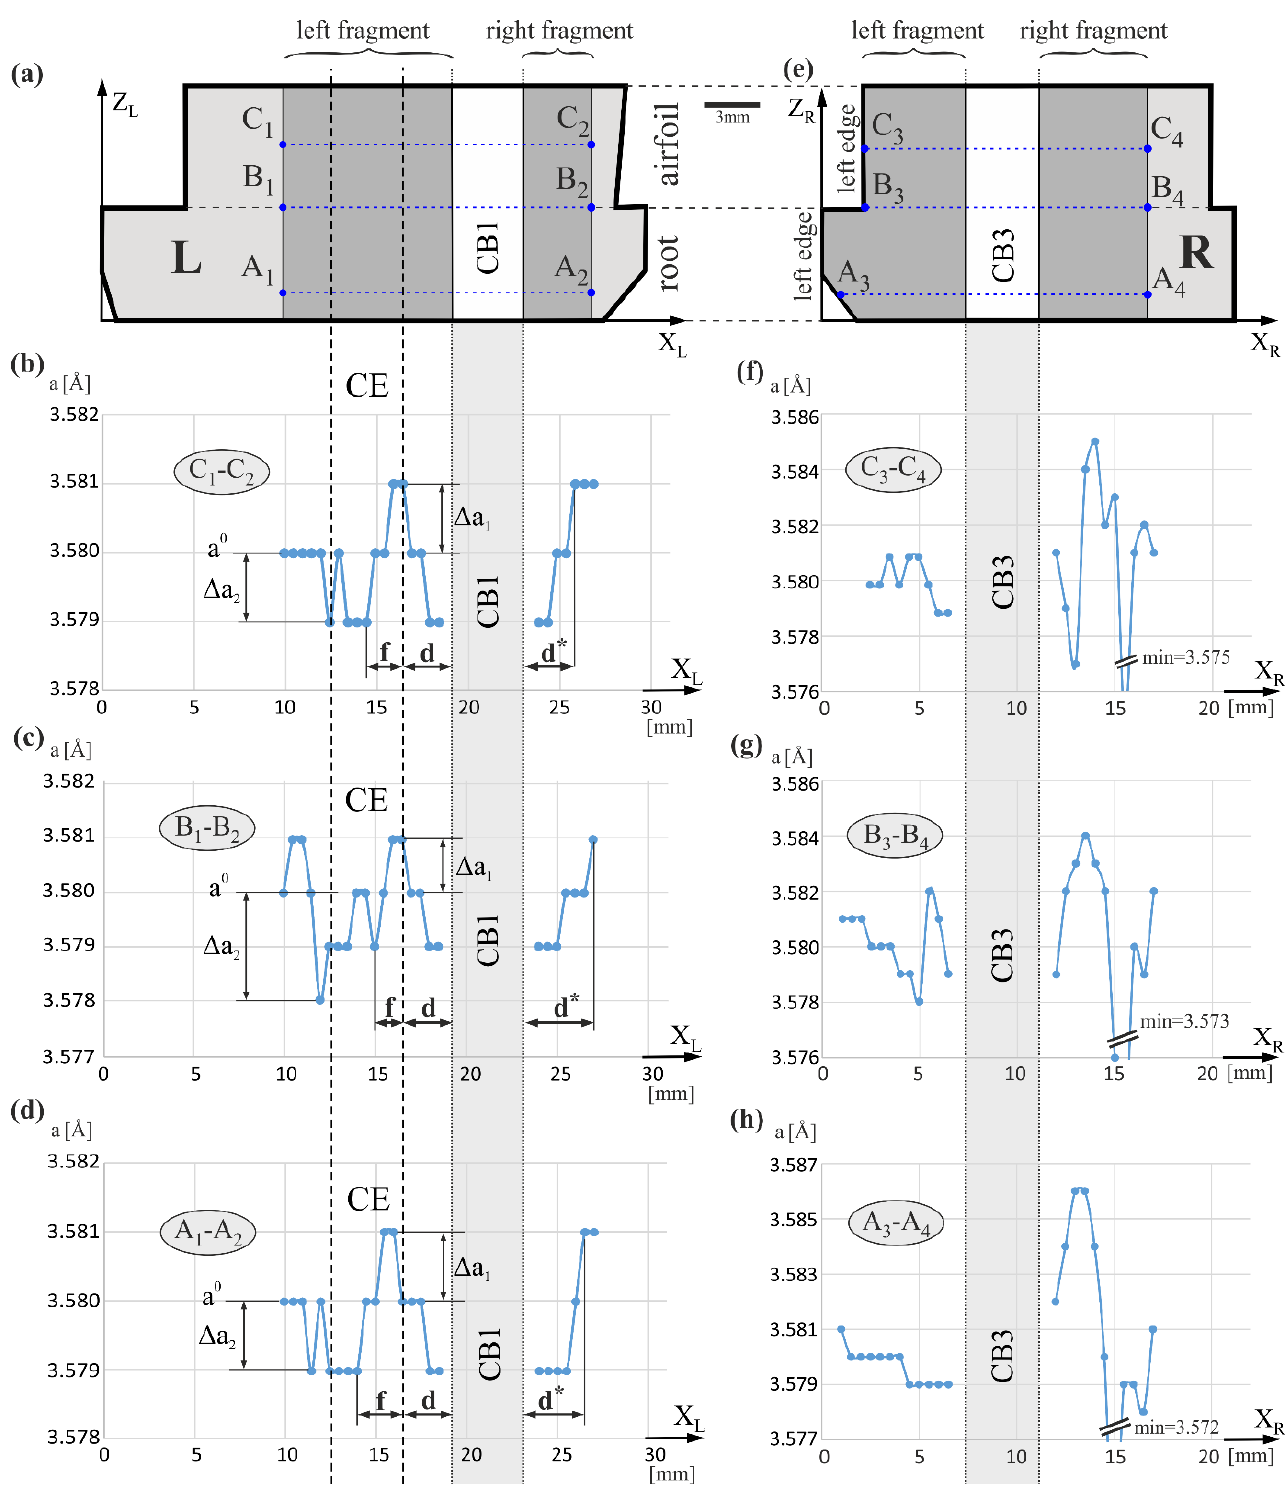
Figure 4. Scheme of the arrangement of the lattice parameter measurement lines ( a , e ) and lattice parameter a values distribution in fragments of the L ( a – d ) and R ( e – h ) surfaces along selected lines perpendicular to the axes X L , X R , and the blade axis Z, as well as, perpendicular to the sidewall of CB1 and CB3 cooling bores in their vicinity. For simplicity, the labels of the measurement axes are replaced by parallel axes X L and X R .